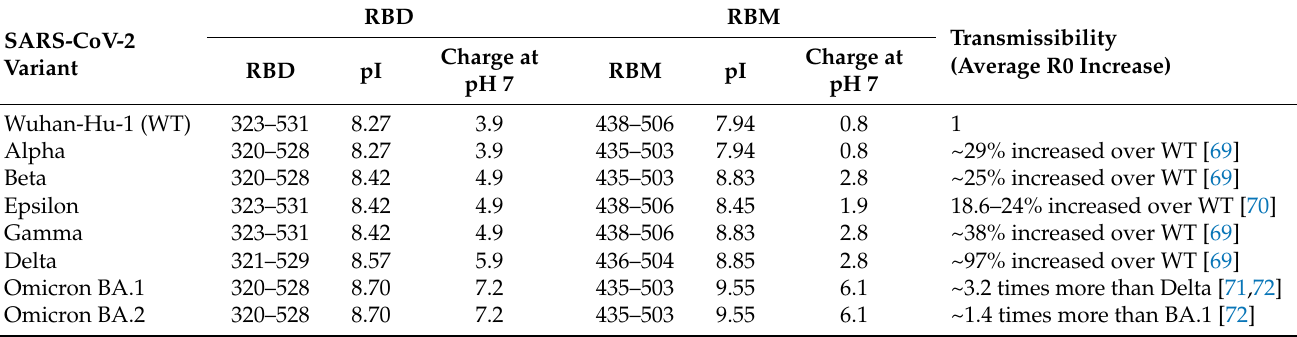
Table 1. The RBDs and RBMs of different SARS-CoV-2 variants, their isoelectric points (pIs), charge at pH 7, and